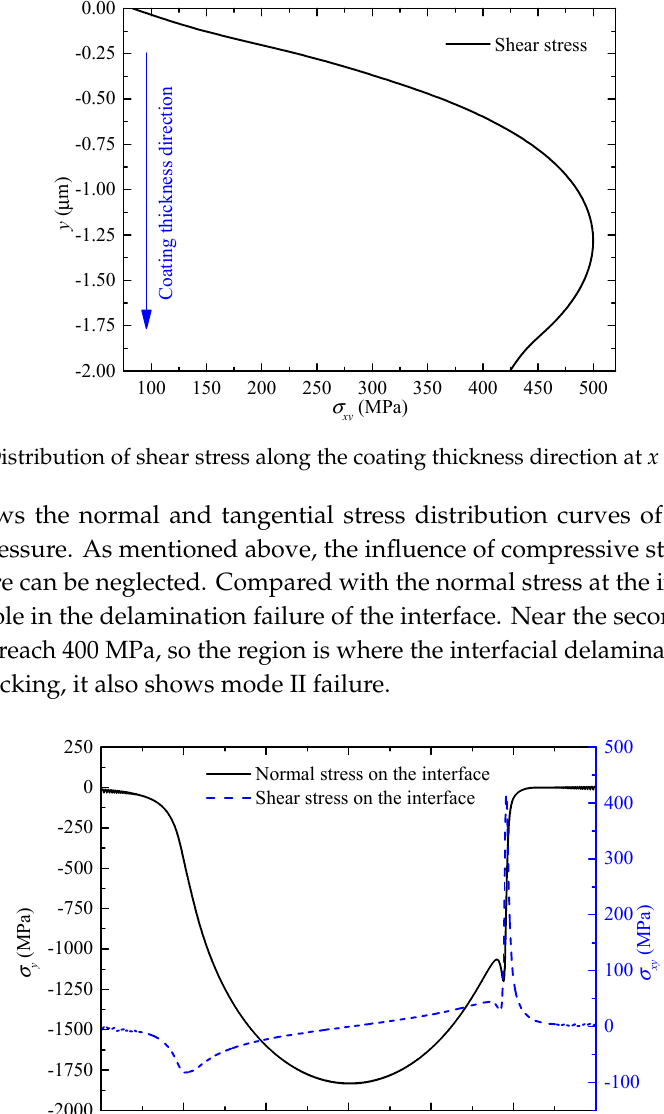
Figure 10. Distribution of normal and shear stresses on the interface.